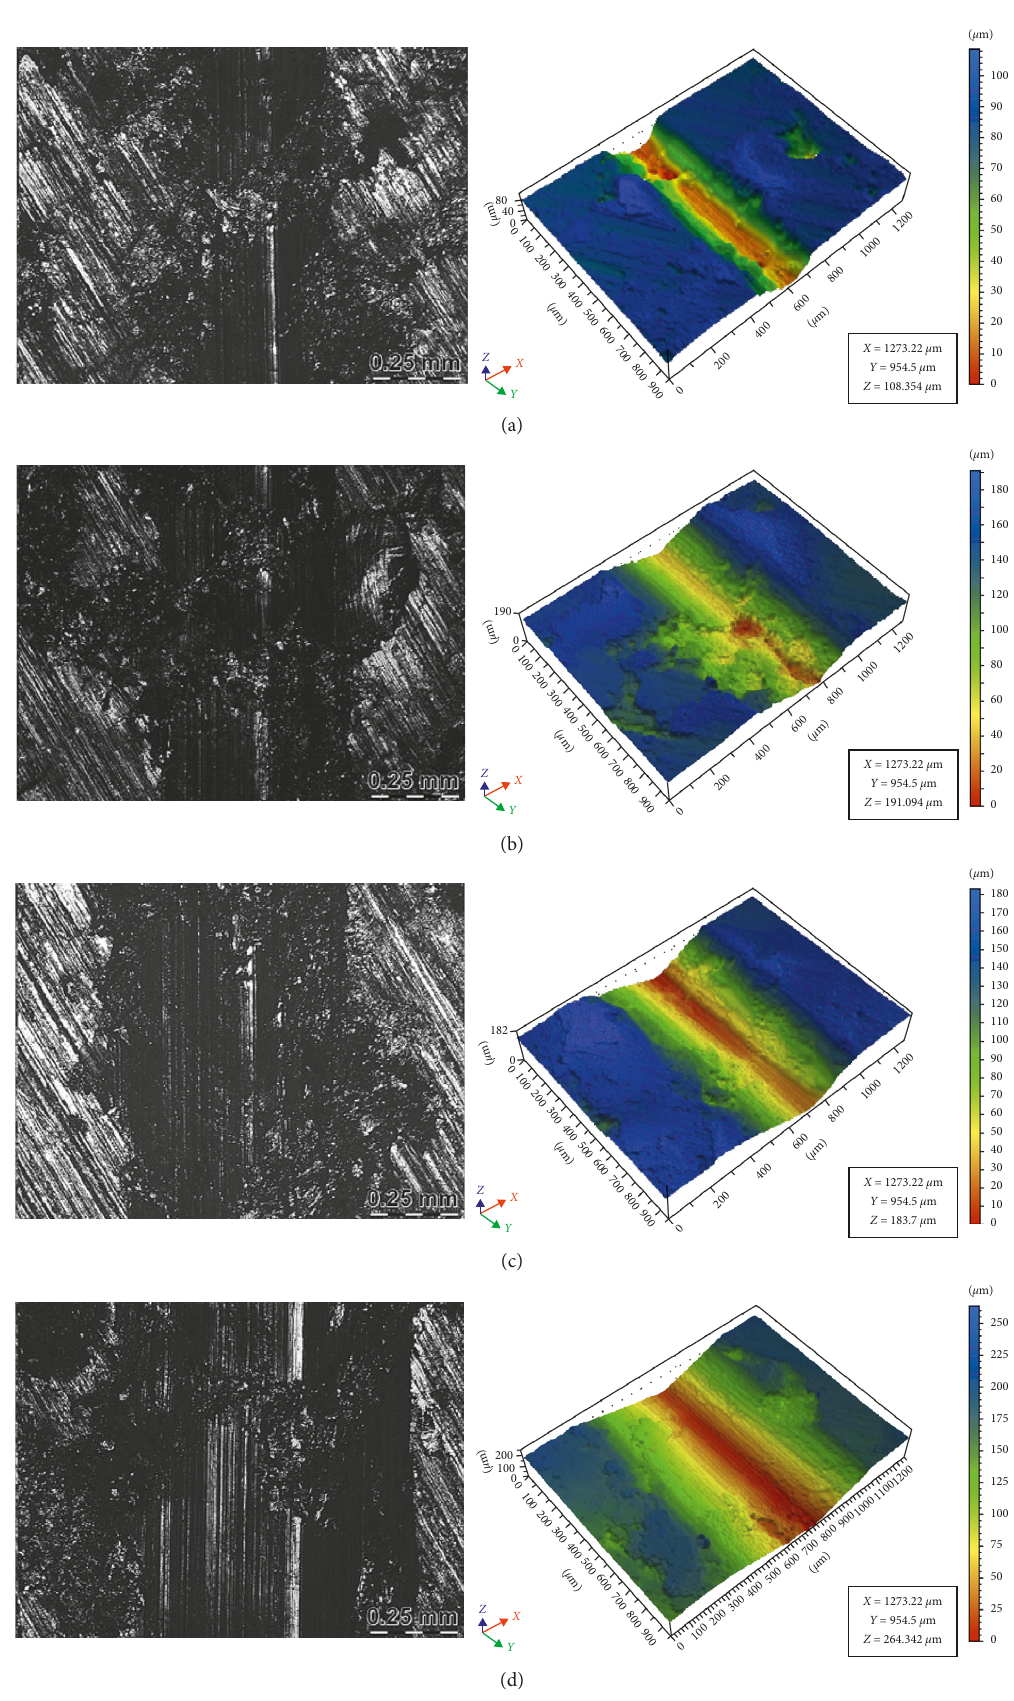
Figure 7: Surface morphology and contour of the grooves under different cutting depths. (a) a 110 μ (d) a p (cid:31)